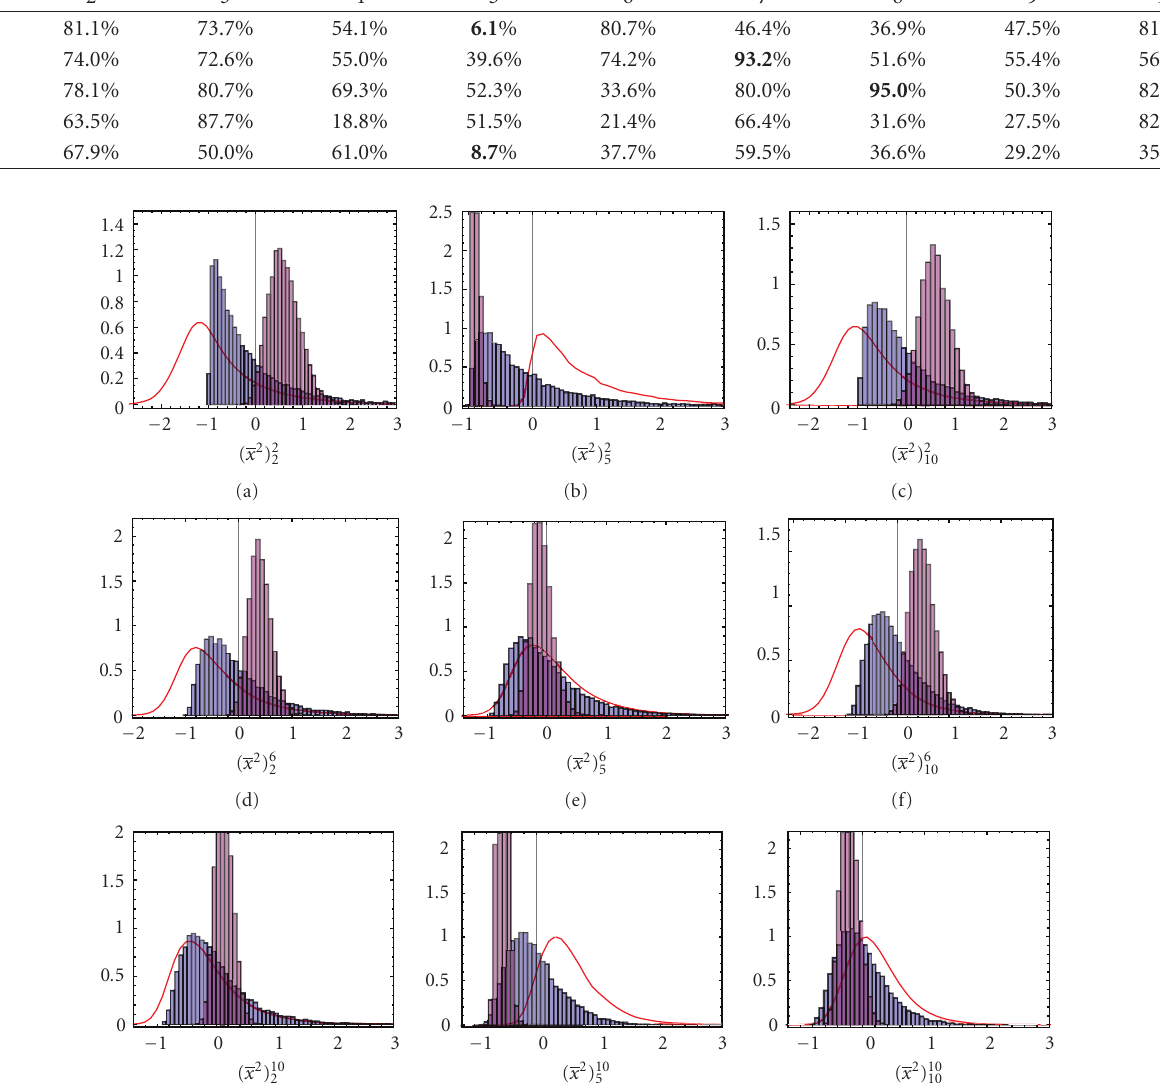
Table 2: Final probabilities of obtaining, in a random Λ CDM Universe, a chi-square value smaller or equal to ( χ 2 ) l temperature maps.